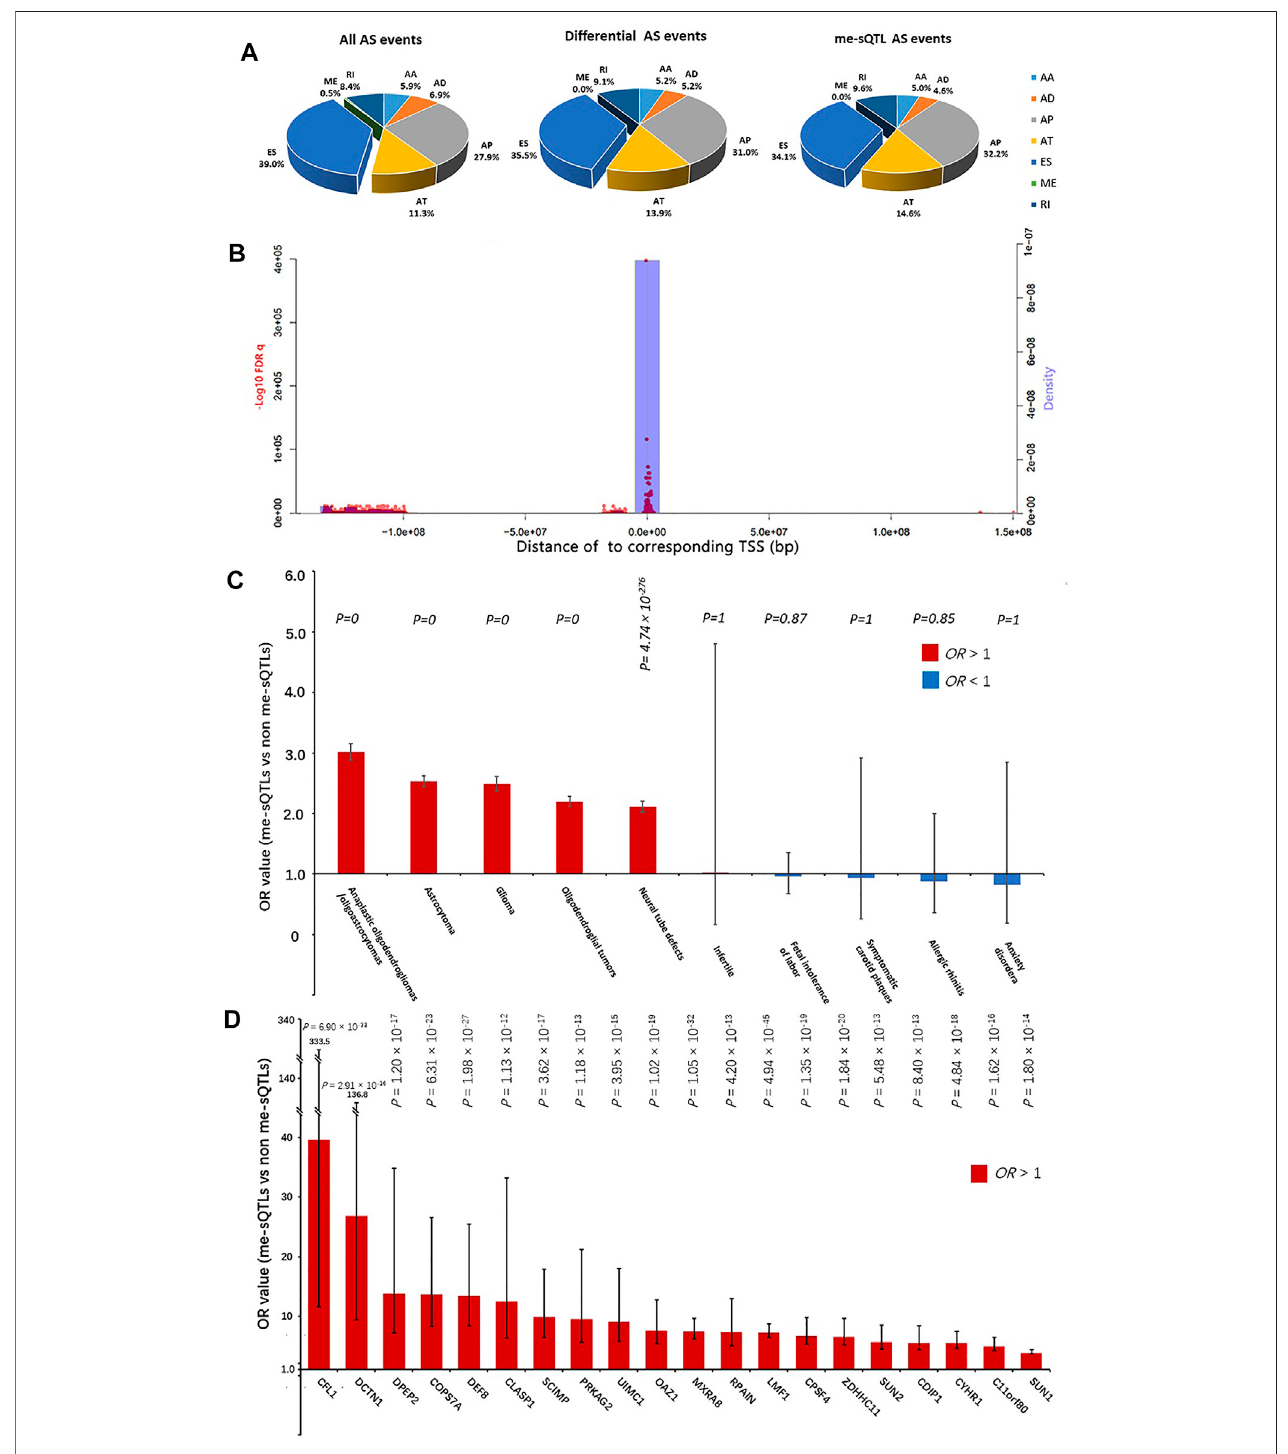
FIGURE 2 | The characteristic of the cis me-sQTLs and the affected AS events. (A) The pie charts show the proportion in all (left), differential (middle) and DNA methylationaffectedASevents(right)annotatedwitheachclass(AA,AD,ES,RI,AP,ATandME),respectively. (B) Thebluebargraphsindicatetherelationshipbetween the abundance of the cis me-sQTLs and the distance of them to TSS of corresponding AS events. The red dots indicate the relationship between the statistical signi fi cance of the cis me-sQTLs associated with AS and the distance ofthem to TSS ofcorresponding ASevents. (C) The disease speci fi cityof the cis me-sQTLs by the two-tailed Fisher ’ s exact test. (D) The glioma speci fi city of the cis me-sQTLs in each gene by the two-tailed Fisher ’ s exact test. The black bars in histogram represent 95% con fi dence intervals.